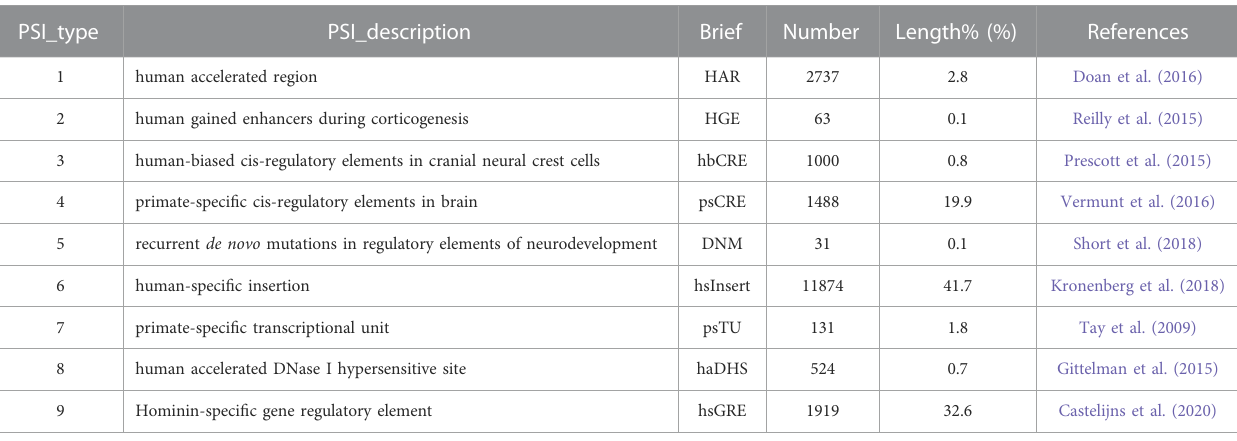
TABLE 1 Summary information of the PSI elements a .